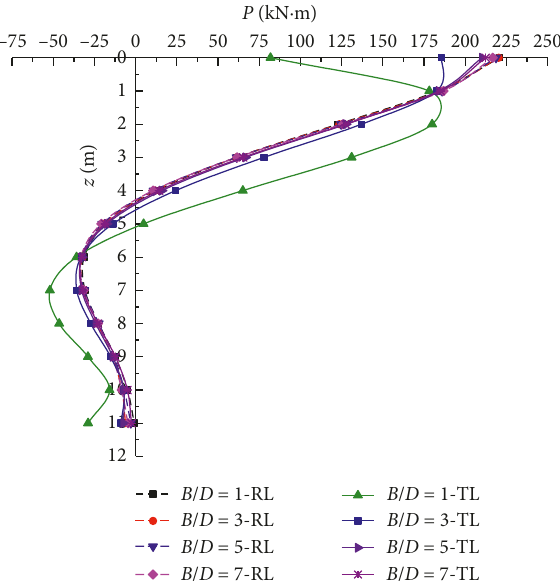
Figure 20: Lateral soil resistance versus depth relationships under different loading directions for the 1V :1H slope at H 0